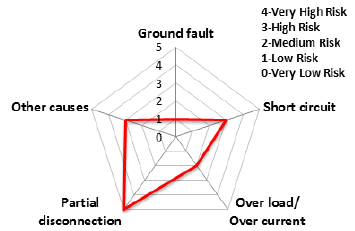
Figure 15. The risk rating for electrical fires in Gwangju.